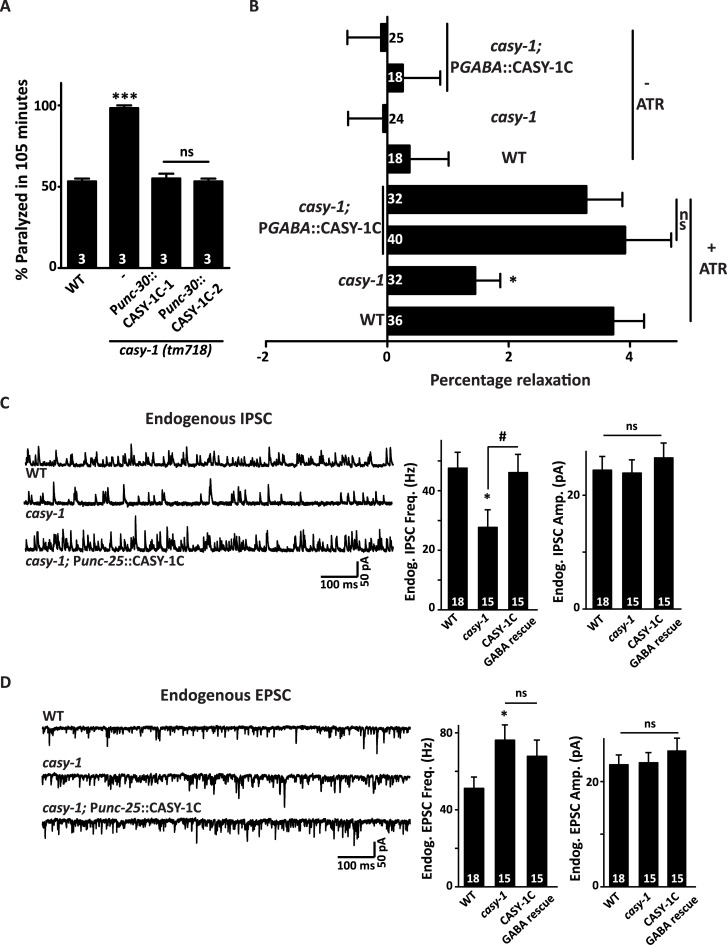
casy-1 mutants show decreased GABAergic synaptic transmission at the NMJ.(A) Expression of the CASY-1C specifically in DD and VD neuronal subtypes using GABAergic motor neuron specific promoter (Punc-30) establish that CASY-1 is explicitly functioning in GABAergic motor neurons to regulate synaptic transmission. Assays were done 3 times as indicated in Figures (~20 C. elegans/ assay). Data are represented as mean ± S.E.M. (***P<0.0001 using one-way ANOVA and Bonferroni's Multiple Comparison Test). “ns” indicates not significant in all Figures. (B) Optogenetic stimulation of GABAergic neurons using Channelrhodopsin (ChR2) [zxIs3 (unc-47p::ChR2(H134R)::YFP)] showed that the casy-1 mutant animals relax significantly less than WT C. elegans upon blue light exposure (percent change in body length before and after optogenetic stimulation). Expressing the CASY-1C isoform under a GABAergic neuron specific promoter (Punc-25) completely rescues the relaxation defect in casy-1 mutant animals. Data is shown for two independent rescue lines. The graph shows the percentage change in body length for both +ATR and–ATR controls. The numbers of animals analyzed for each genotype are indicated. Data are represented as mean ± S.E.M. (*p<0.01 using one-way ANOVA and Bonferroni's Multiple Comparison Test). “ns” indicates not significant in all Figures. (C) mIPSCs were recorded from body wall muscles of adult animals for the indicated genotypes. Representative traces of mIPSCs and summary data for frequency and amplitude are shown. The casy-1 mutants showed a significant decrease in mIPSCs rate compared to WT C. elegans, suggesting a decreased GABAergic neurotransmission at the NMJ. The mIPSC amplitude, however, remains unaltered suggesting normal muscle responsiveness in the mutant. The decreased mIPSCs rate of casy-1 mutants can be significantly rescued by expressing CASY-1C specifically in GABA motor neurons (Punc-25). (D) Depicts traces and quantified data for the mEPSCs recorded from the C. elegans body-wall muscles. There is a subtle but significant increase in mEPSC frequency in casy-1 mutants, and this defect was not rescued by expressing CASY-1C in GABA motor neurons. For both C and D, the number of animals analyzed for each genotype is indicated. Data are represented as mean ± S.E.M. *p<0.05 with respect to WT and # p<0.05 with respect to casy-1 mutants, using the one-way ANOVA with Dunnett’s post test).